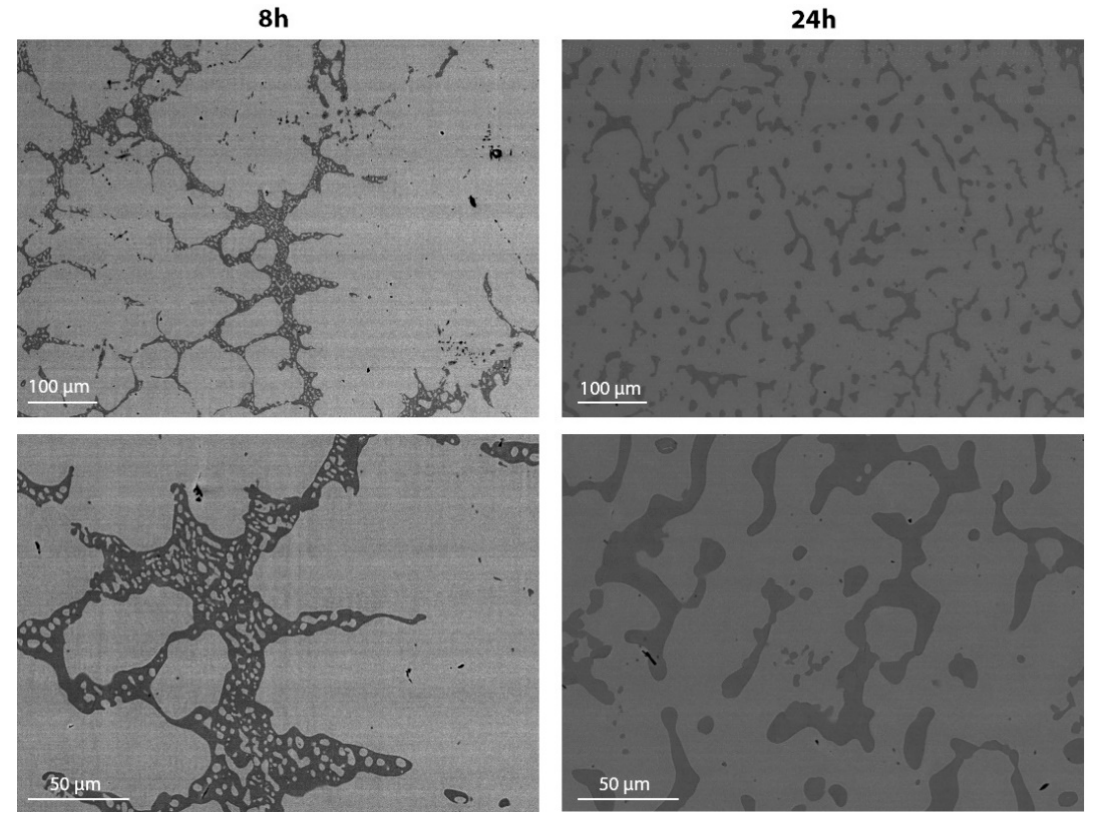
Figure 7. SEM micrographs at 500× (up) and 1500× (down) magnification.